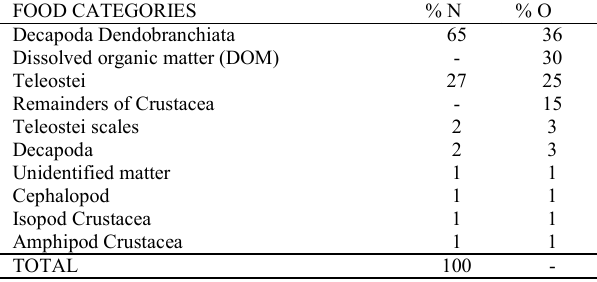
Table 2. Food categories for I. parvipinnis on the coast of Ilhéus – BA (% N = numeric frequency; % O = frequency of